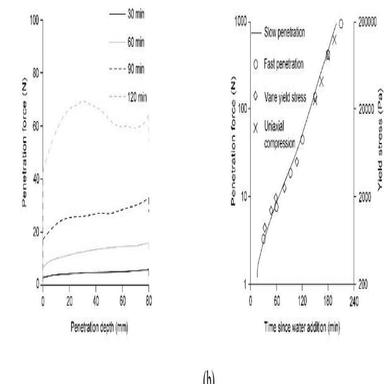
(a) Fast penetration test at different times (using conical tip); (b) The evolution of penetration force and yield stress obtained by using different approaches. Both (a) and (b) adapted from .